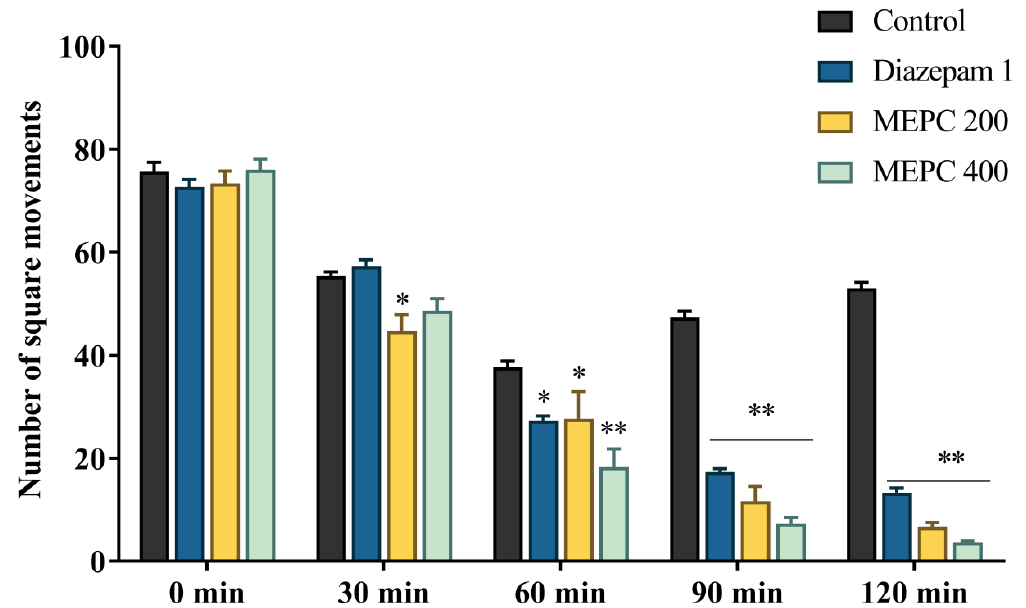
Figure 2. Locomotor activity of methanol extract of P. calocarpa (MEPC) and diazepam on open field test in mice. Values represented as mean ± SEM ( n = 5). * p < 0.01 and ** p < 0.001 considered as significantly different from the control (two-way ANOVA with repeated measures) .